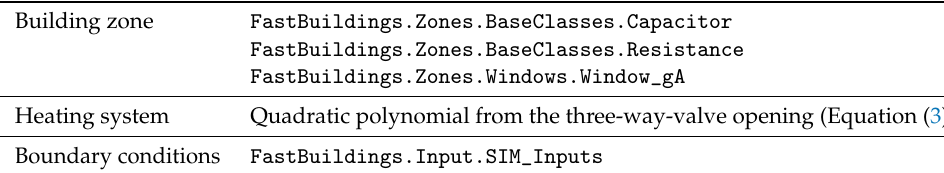
Table 2. Modelica components used for the grey-box